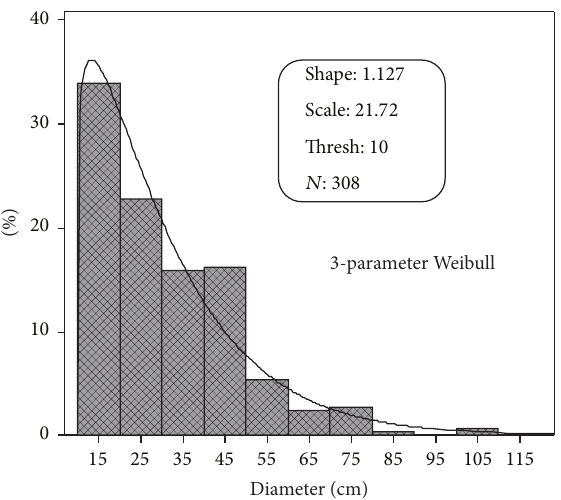
Figure 4: Diameter class-size distribution in the Sudanian zone.